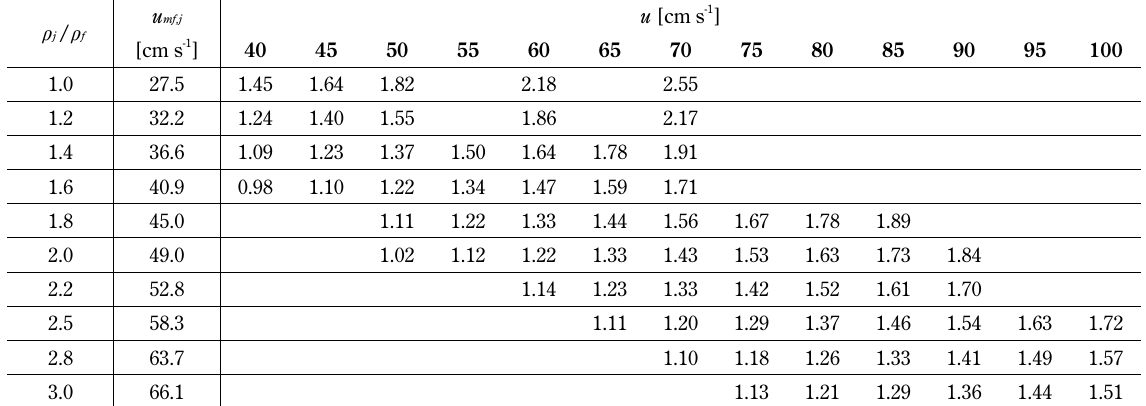
Table 3 Dimensionless velocities for the combinations of density ratios and actual velocity